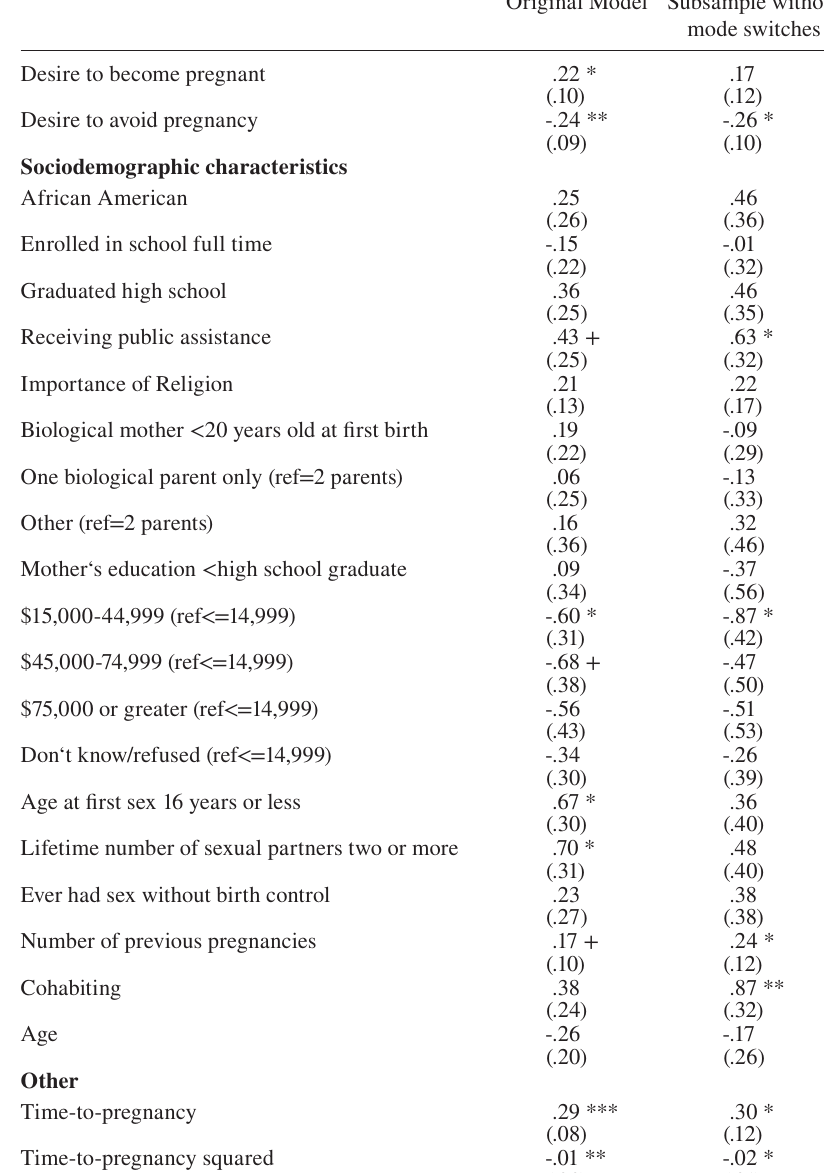
Logistic regression estimates of the effects of positive and negative pregnancy desires on the hazard of pregnancy Original Model Subsample